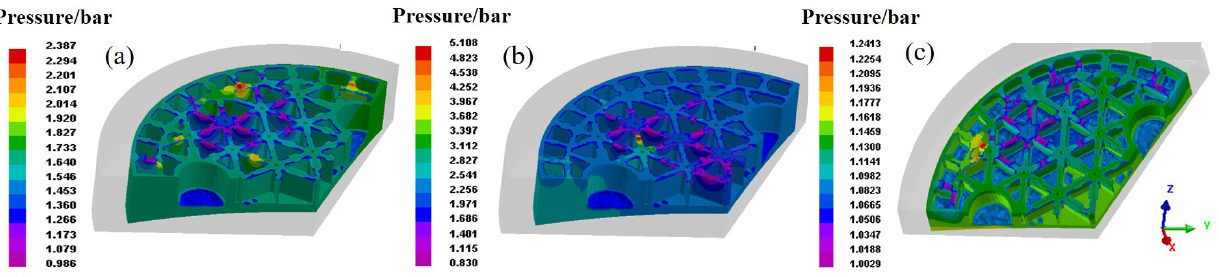
Figure 13. Pressure distribution for gating system with exhaust hole after gel-casting process. ( a ) 20 mm/s; ( b ) 10 mm/s; ( c ) 5